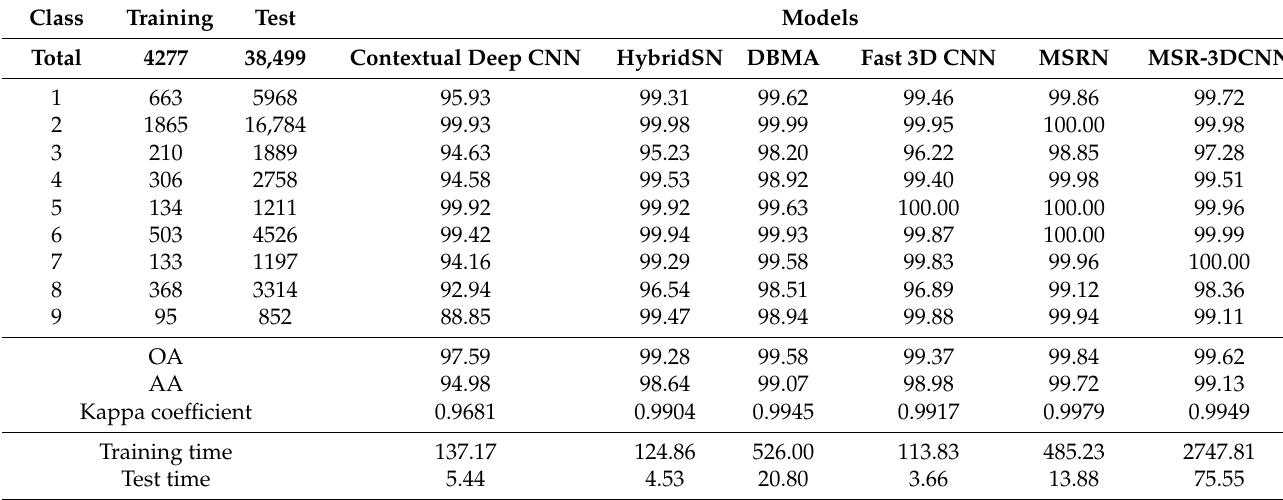
Table 6. F1 Score(%) for each class, OA (%), AA (%), and Kappa Coefficient values for the entire dataset, training time (s), and test time (s) using ( 9 × 9 ) patch size and 10% samples for training on the PU